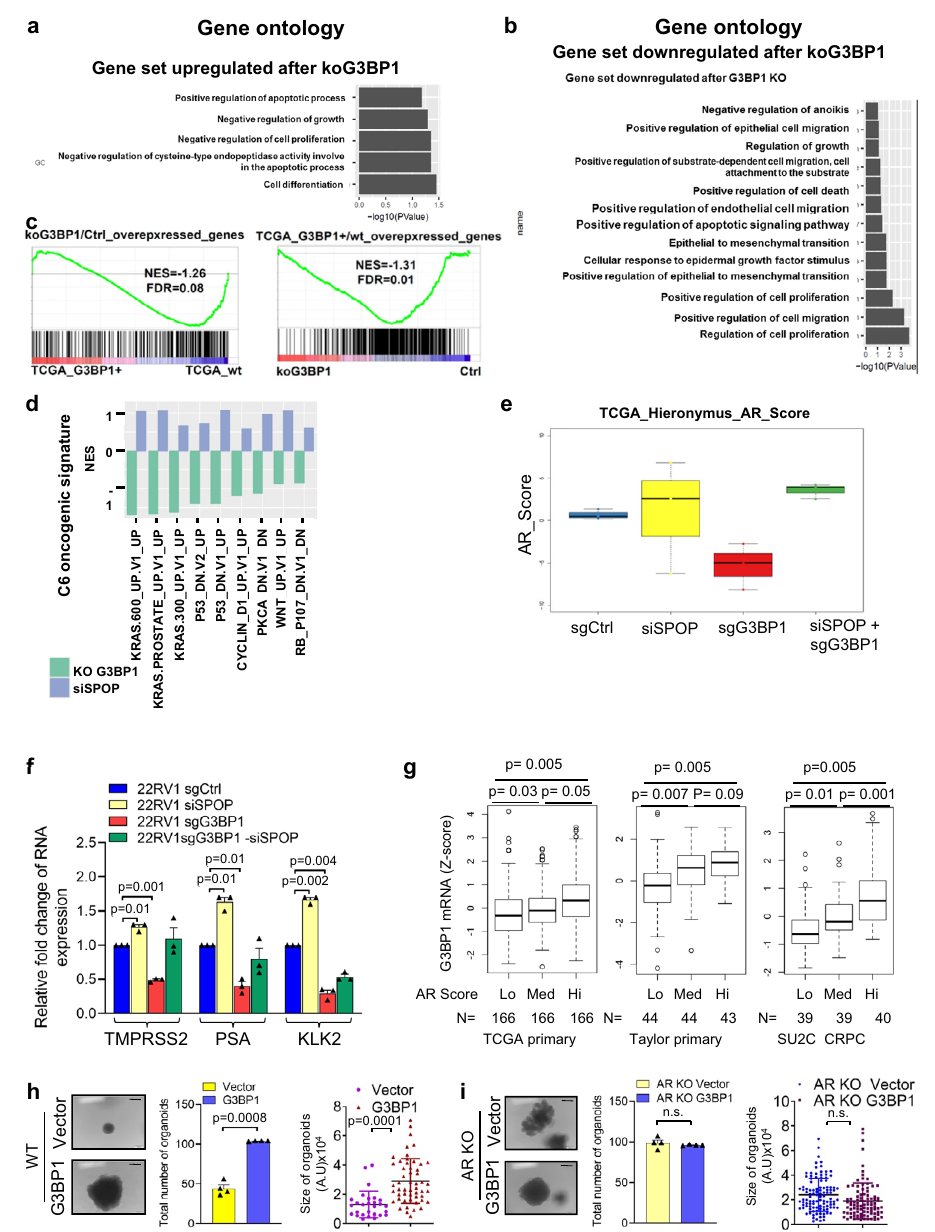
Fig. 4 G3BP1 deregulates potential oncogenic pathways and activates AR-mediated signaling. a , b Enriched signaling pathways of upregulated genes ( a ) and downregulated genes ( b ) after G3BP1 knockout (KO) by Gene Ontology analysis. c GSEA analysis of G3BP1 transcriptional signature from current study and TCGA cohort. d Distinct enriched oncogenic signatures between G3BP1 KO and siSPOP samples compared to normal samples via GSEA. e , f 22Rv1-sgCtrl and 22Rv1-sgG3BP1 cells were transfected with non-targeted or SPOP siRNA and designated as sgCtrl, siSPOP, sgG3BP1, and sgG3BP1 + siSPOP. e Inverse correlation and complementation of AR score 39 in distinct genotypes. n = 3 biologically independent samples. In box plots, the center line represents median value, box limits represent 25% and 75% quantiles, and the top and bottom lines represent minimal and maximal values, respectively. f RT-qPCR for AR target genes, TMPRSS2, PSA, and KLK2 as indicated. Error bars ±S.E.M Paired t -test. g G3BP1 mRNA levels showed a stepwise upregulation with increasing AR output scores in different PCa cohort patients [TCGA, Provisional 2019 77 ; Taylor et al. 64 ; SU2C, Robinson et al. 15 ]. Unpaired t -test. p values are indicated in fi gure. In box plots, the center line represents median value, box limits represent 25% and 75% quantiles, and the top and bottom lines represent minimal and maximal values, respectively. h DOX-inducible empty vector (Ctrl) and pCW57.1-FLAG-G3BP1 (overexpressed) stable lines were generated from wild-type mPECs. n = 28 (Ctrl) and n = 52 (G3BP1 overexpressed) organoids examined over three independent experiments. Paired t -test ( i ) DOX-inducible empty vector (Ctrl) and pCW57.1-FLAG-G3BP1 (overexpressed) stable lines were generated from AR KO mPECs. n = 109 (Ctrl) and n = 109 (G3BP1 overexpressed) organoids examined over three independent experiments. Photomicrographs of representative mouse prostate organoids (scale bar, 200 µ m) from the indicated mouse genotype following quanti fi cation of organoids (number and size). Unpaired t -test, Data are average of three independent experiments. Error bars, ±S.E.M. Source data are provided as a Source Data fi